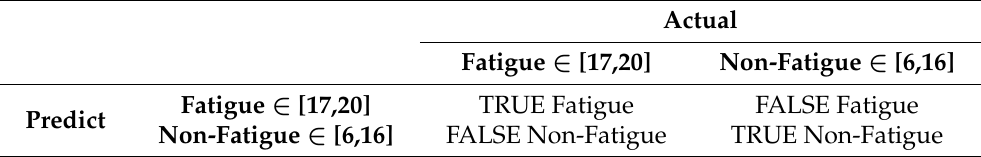
Table 4. Fatigue detection confusion